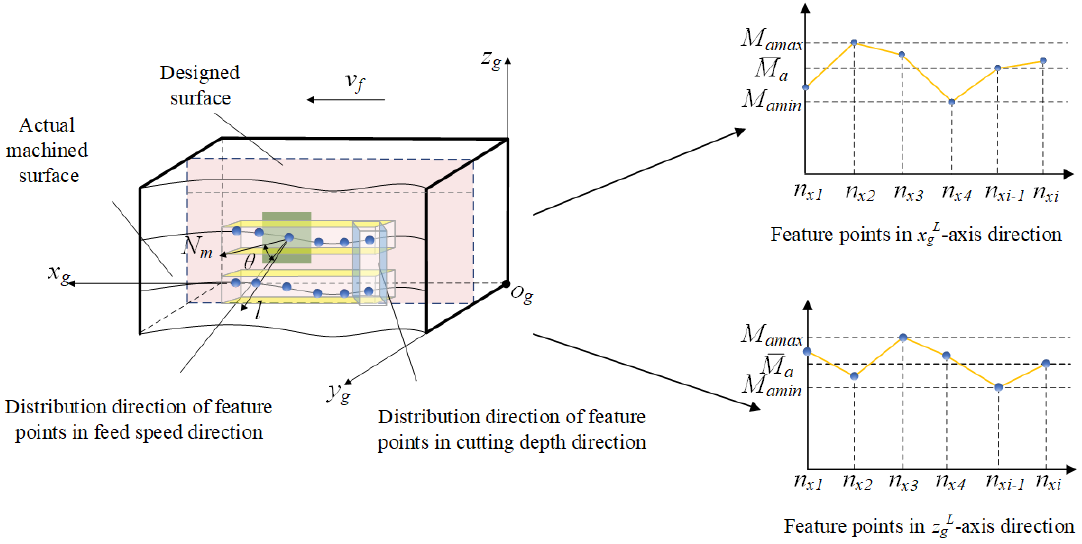
Figure 5. Consistency analysis model of the machined surface error distribution.